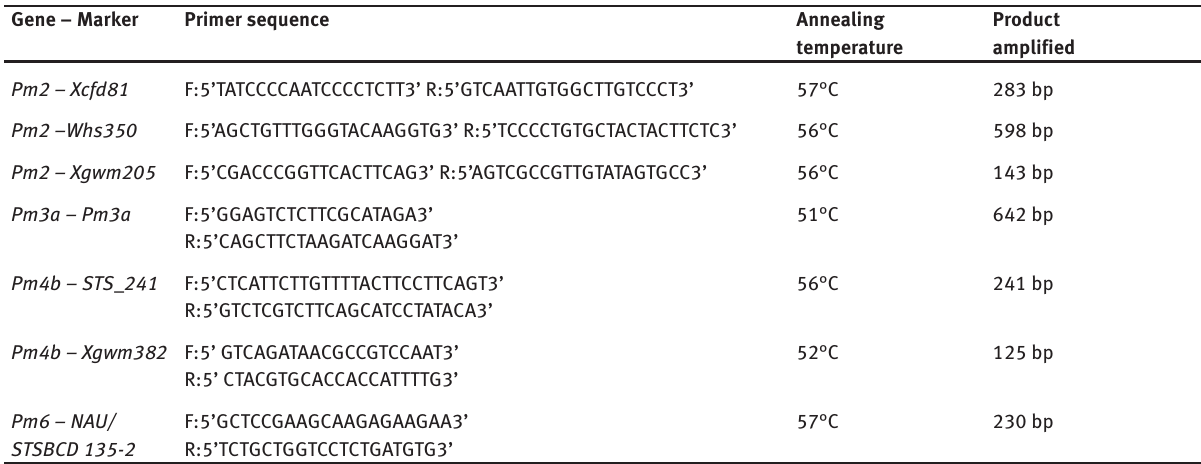
Table 2: Primer sequences and their annealing temperature in the identification of the Lr11 , Lr13 , Lr16 , Lr26 genes. Gene –